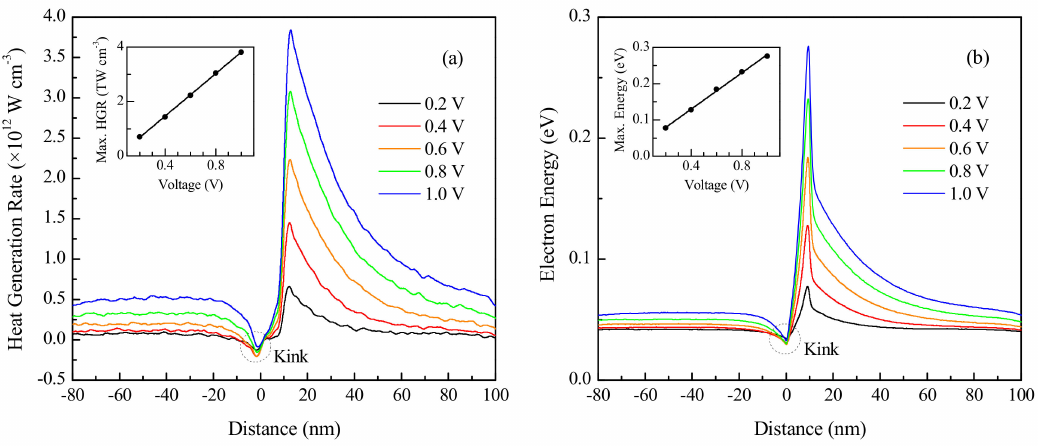
Figure 4. E ff ect of voltage on ( a ) heat generation and ( b ) electron energy over a 10 nm long channel n + nn + silicon